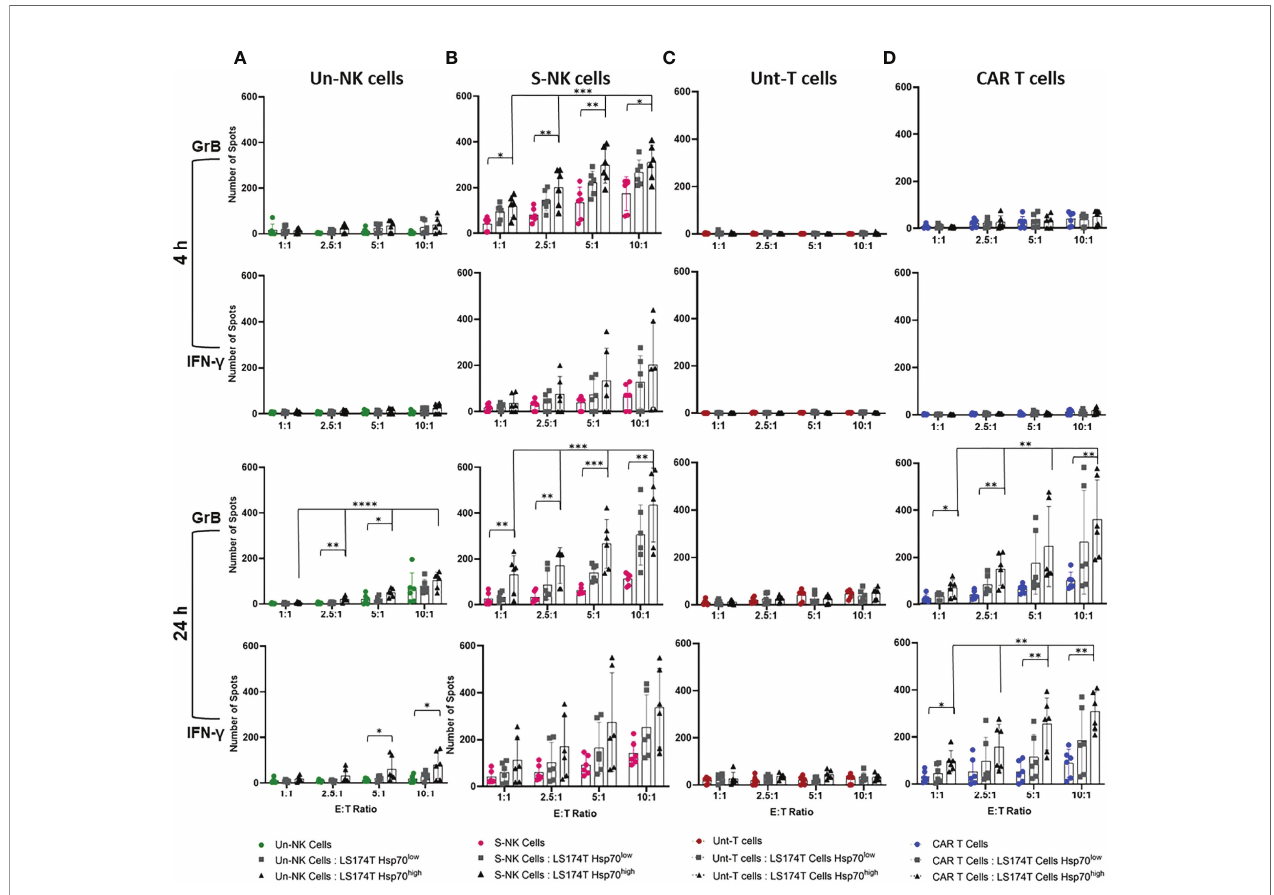
FIGURE 4 | Quanti fi cation of granzyme B (GrB) and interferon (IFN)- g release by effector cells in co-cultures with target cells. Effector cells were co-cultured with Hsp70 high and Hsp70 low LS174T target cells (E:T 1:1, 2.5:1, 5:1, 10:1). (A) Unstimulated (Un) NK cells, (B) TKD/IL-2 stimulated (S) NK cells within PBMC preparations, parallel to (C) untransduced (Unt) T cells, (D) transduced anti-Hsp70 CAR T cells. The amount of released GrB and IFN- g was measured by double- color FluoroSpot assay after 4 or 24 hours. The number of spots at each indicated E:T ratio is represented as the mean of independent duplicates of three individual donors ± SD (*p ≤ 0.05, **p ≤ 0.01, ***p ≤ 0.001, ****p ≤